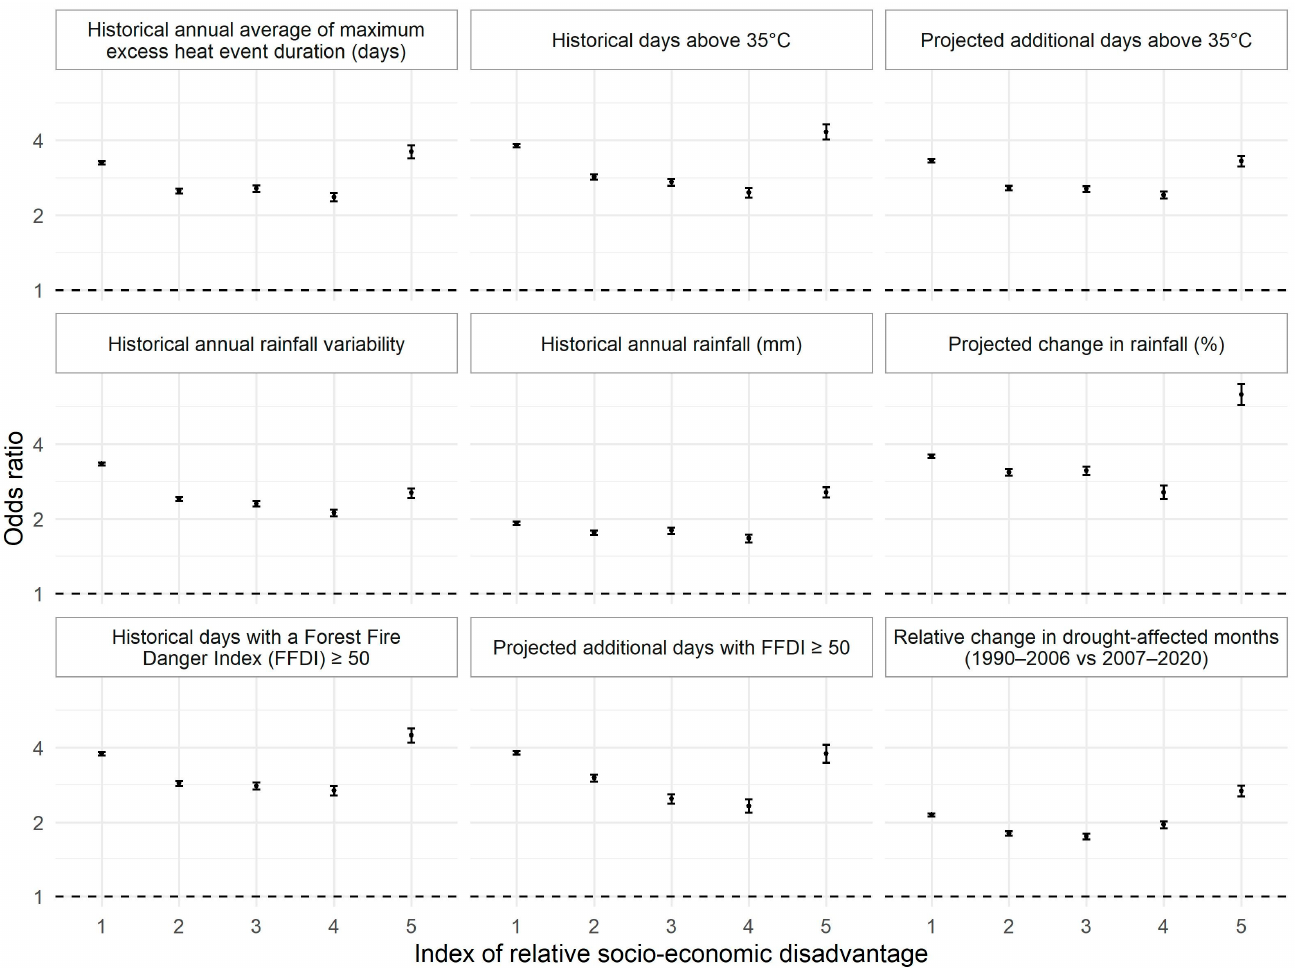
Figure A1. Climate exposure estimates by Aboriginal versus non-Aboriginal usual resident popu- lations stratified by the Index of Relative Socioeconomic Disadvantage (IRSD).